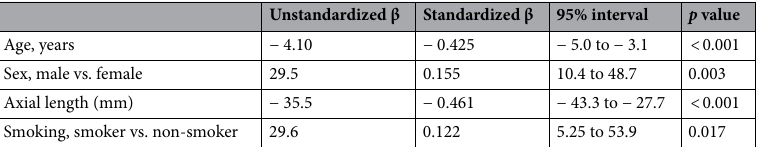
Table 5. Multiple regression analysis to identify factors associated with subfoveal choroidal